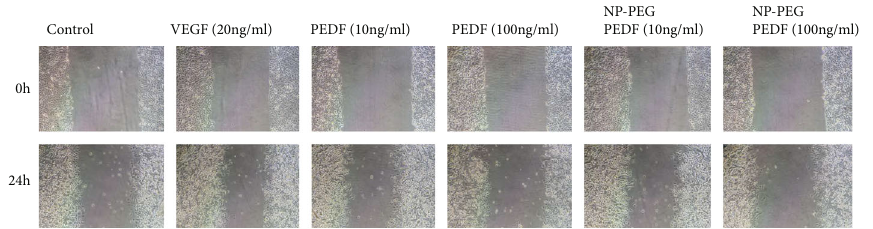
Figure 5: Cell scratch test results. E ff ects of PEDF and NP-PEG-PEDF on HUVEC scratch wound healing under high glucose (30 mmol/L).